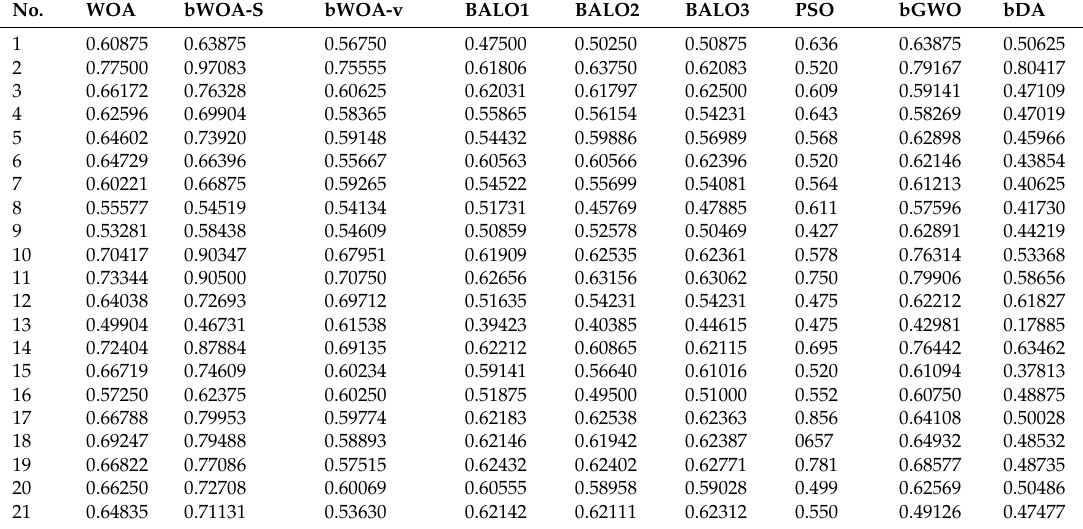
Table 14. Average selection size on the different datasets averaged for the compared algorithms over the three initialization methods.